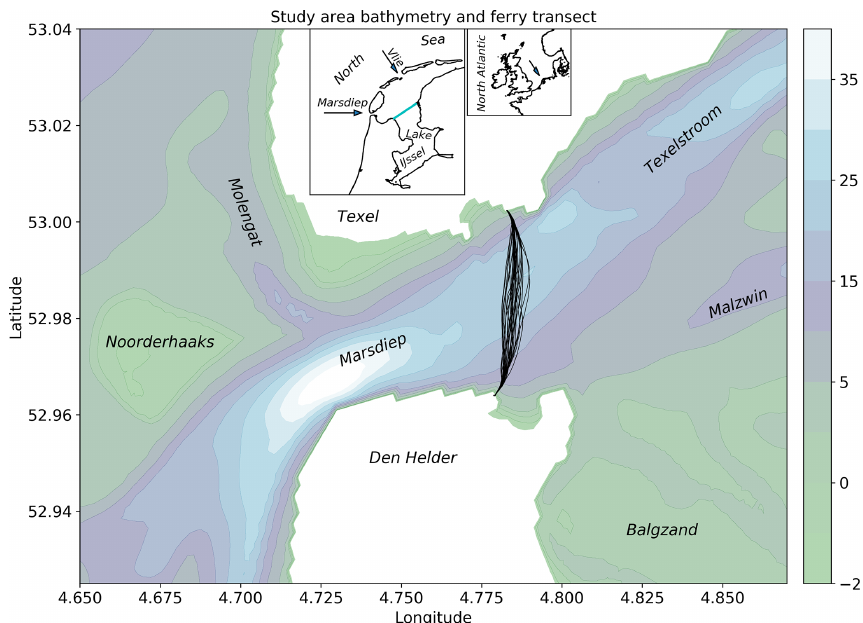
Figure 1. Study area with a selection of ferry crossing trajectories. Contours are depths below mean sea level in metres. Insets: wider area with arrows pointing to the study area in the Marsdiep inlet and the Vlie inlet; the blue line is the closure dam